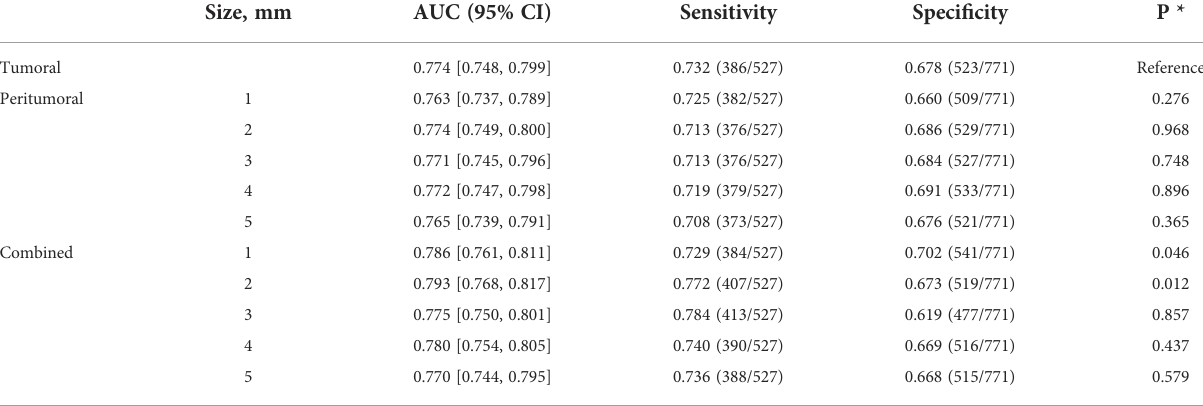
TABLE 2 Benign/malignant classi fi cation performance of radiomics models in patient level.